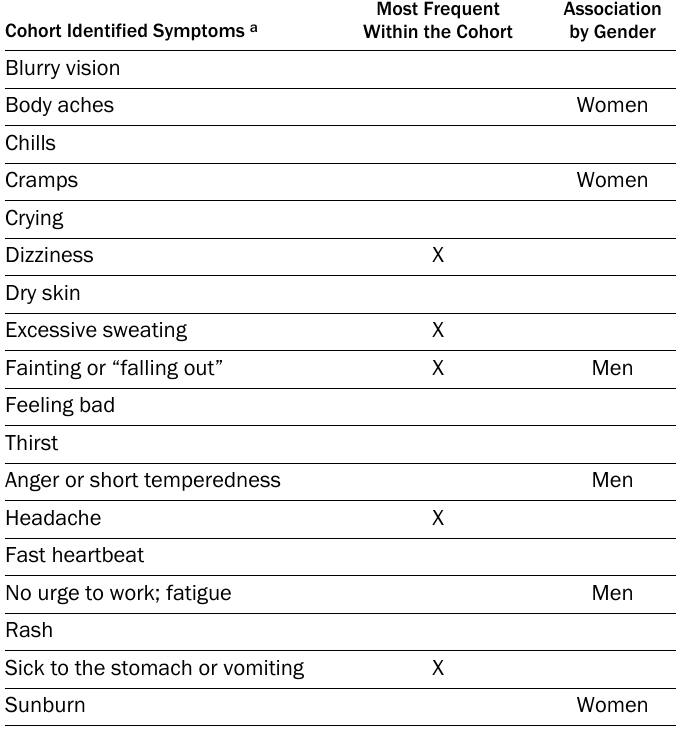
Table 6. Inventory of Identified Symptoms Related to